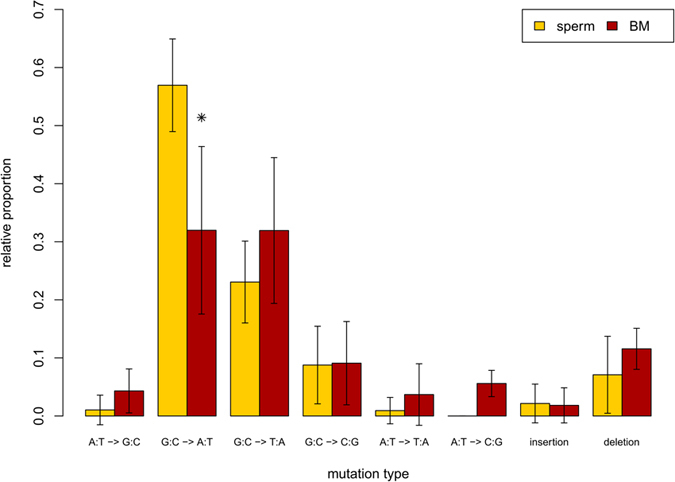
Comparison of the proportion of spontaneous mutation types in the lacZ gene collected from sperm and bone marrow.*Indicates significant differences (p < 0.05) between tissues. Bone marrow data are from a previously published study16.